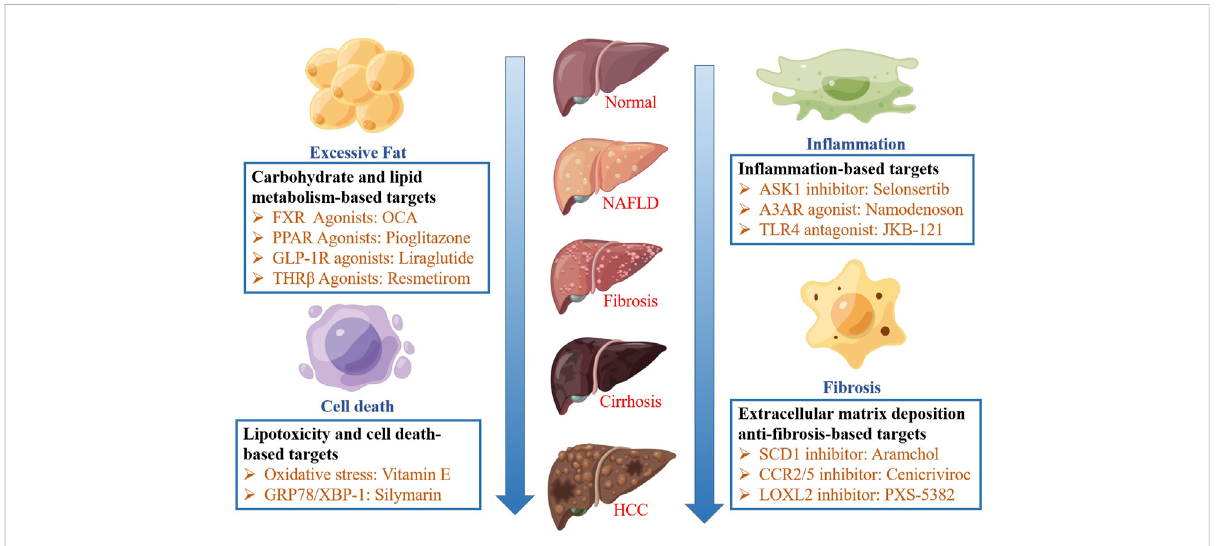
FIGURE 1 The pathophysiology and therapeutic strategies of NAFLD. The therapeutic targets of NAFLD can be divided into four categories: carbohydrate and lipid metabolism-based, lipid toxicity and cell death-based, in fl ammation-based, and extracellular matrix deposition anti- fi brosis-based